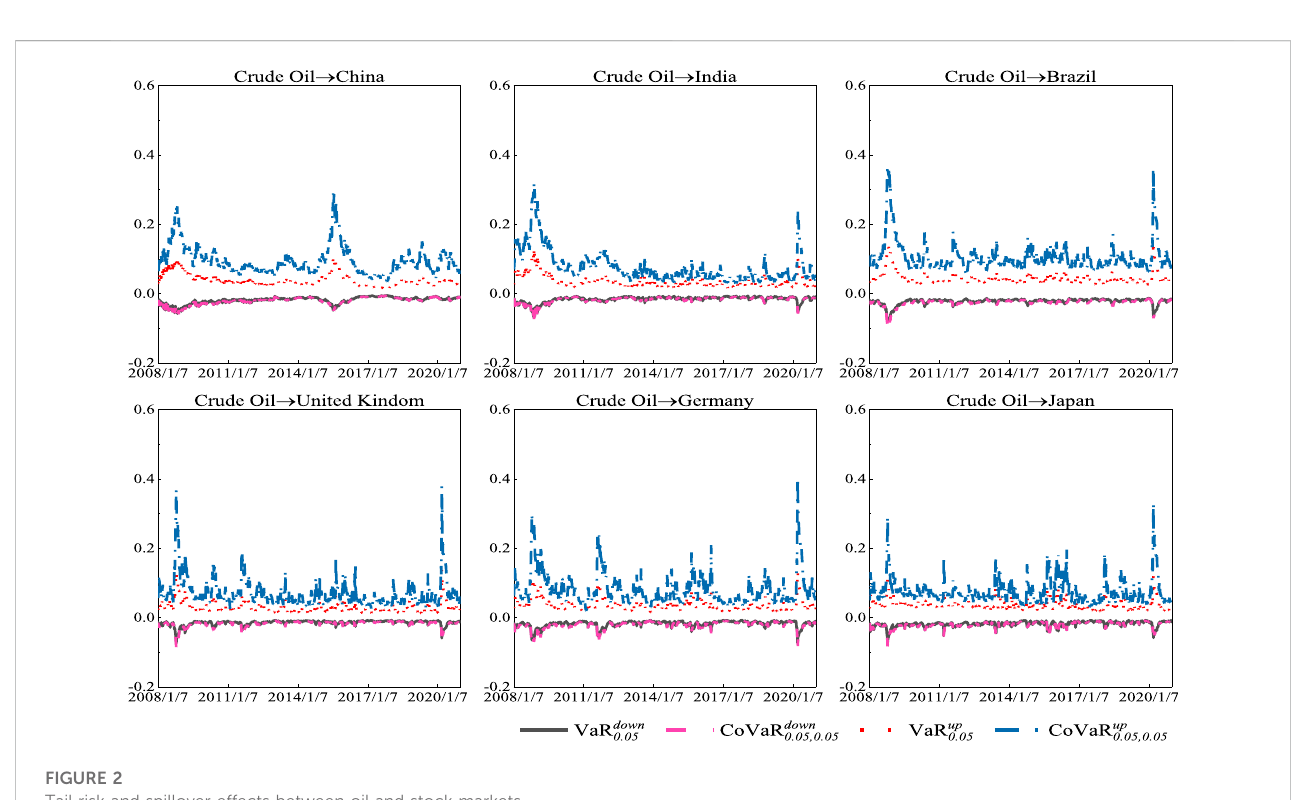
FIGURE 2 Tail risk and spillover effects between oil and stock